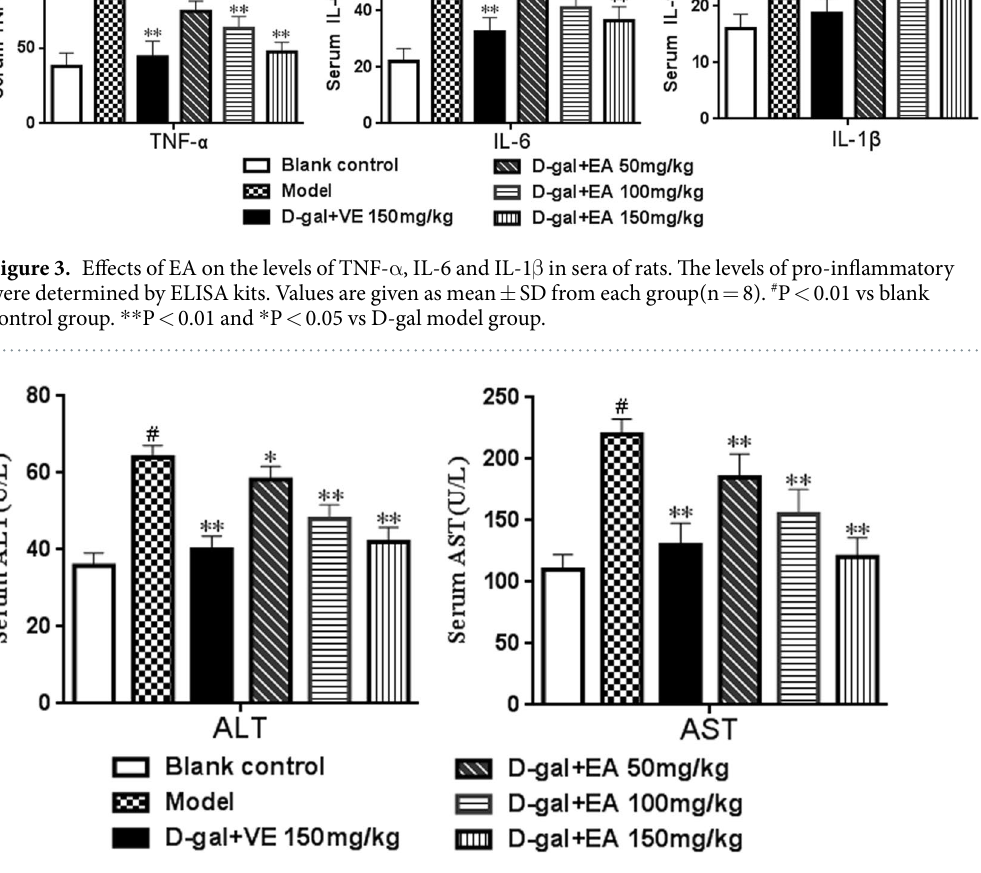
Figure 4. Effect of EA treatment on on the levels of ALT and AST in sera of rats. Date are presented as mean ± SD from each group(n = 8). # P < 0.01 vs blank control group. ** P < 0.01 and * P < 0.05 vs D-gal model